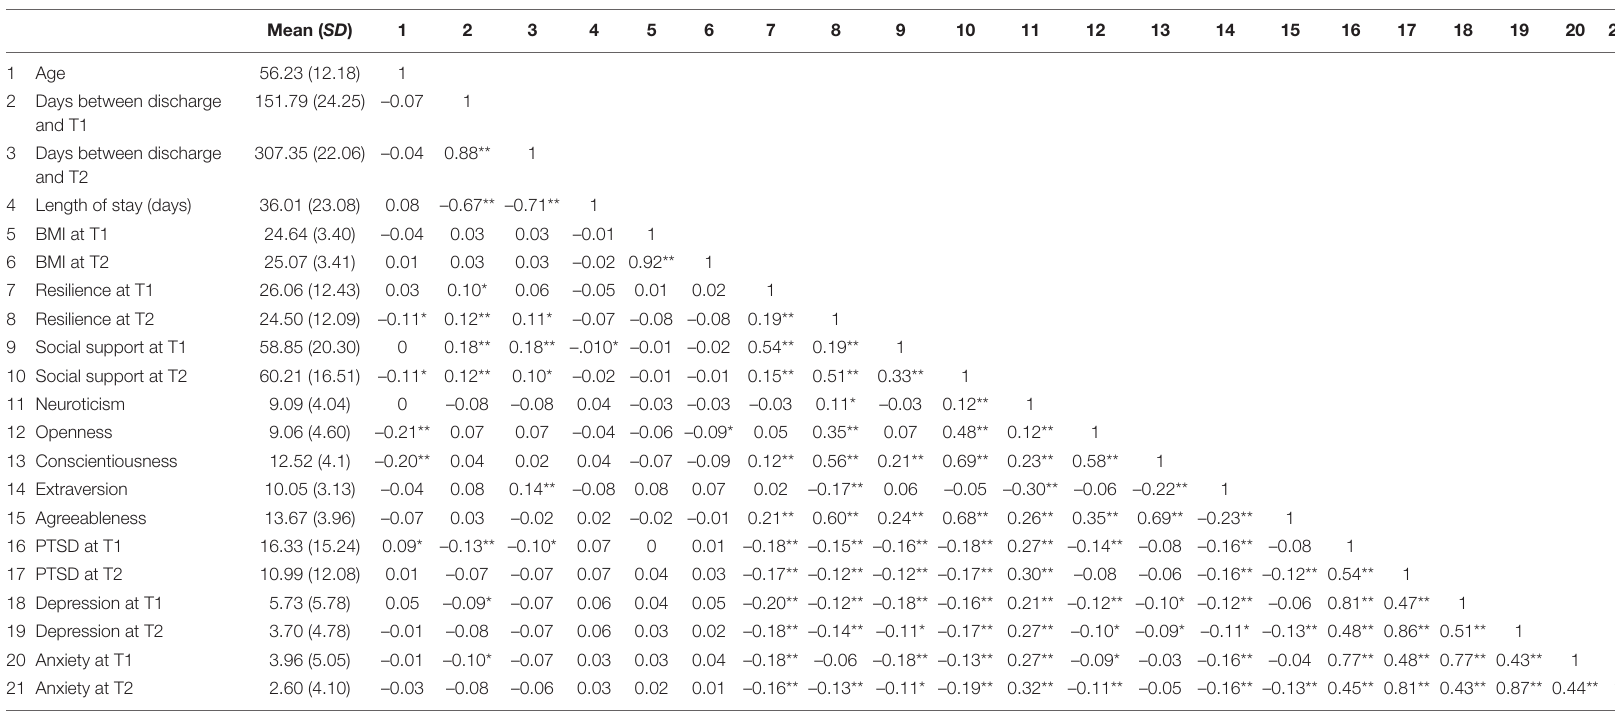
TABLE 1 | Pearson correlation of the variables of the